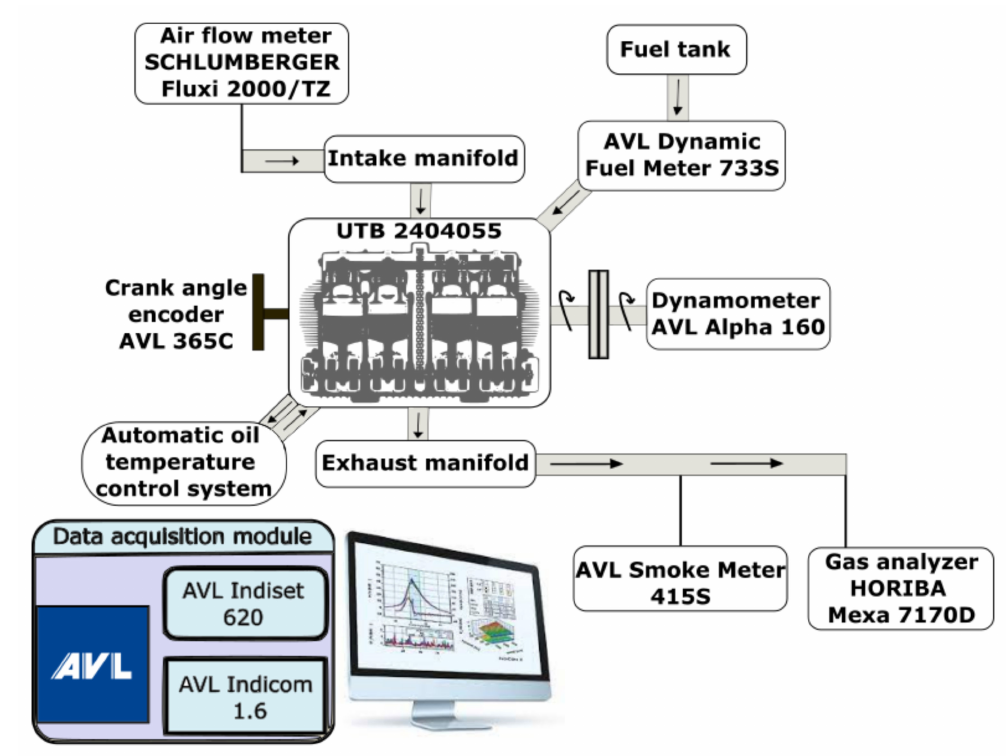
Figure 1. Engine test bench